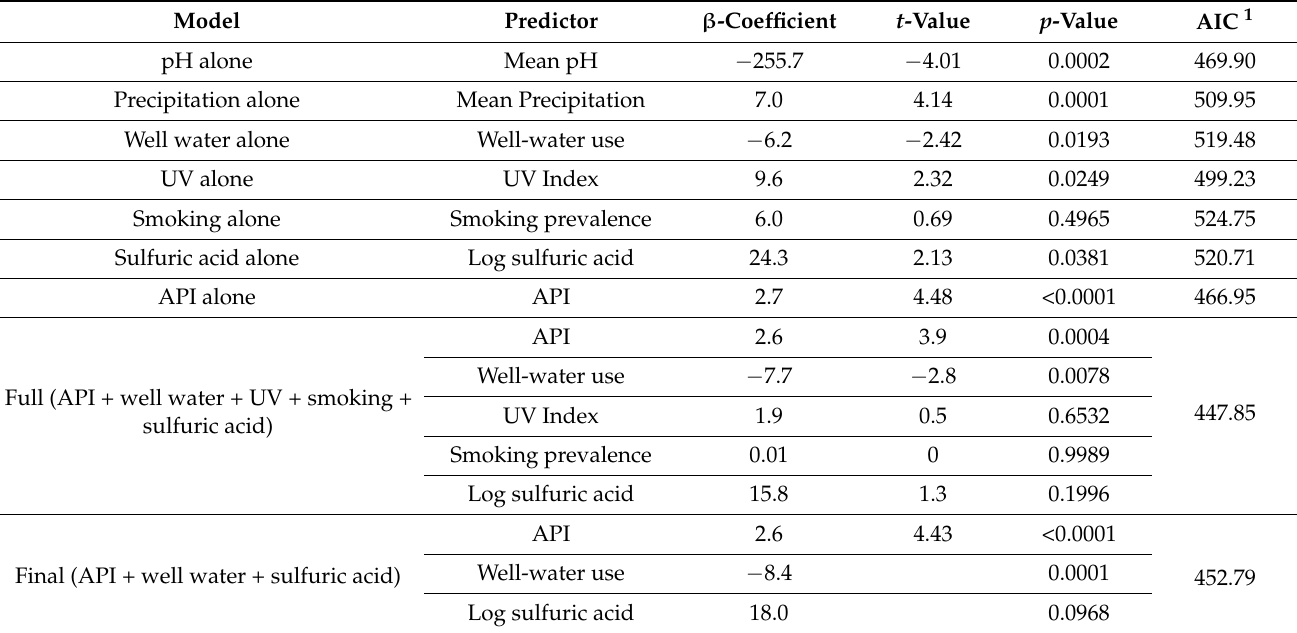
Table 2. Regression models results for predicting PD prevalence.